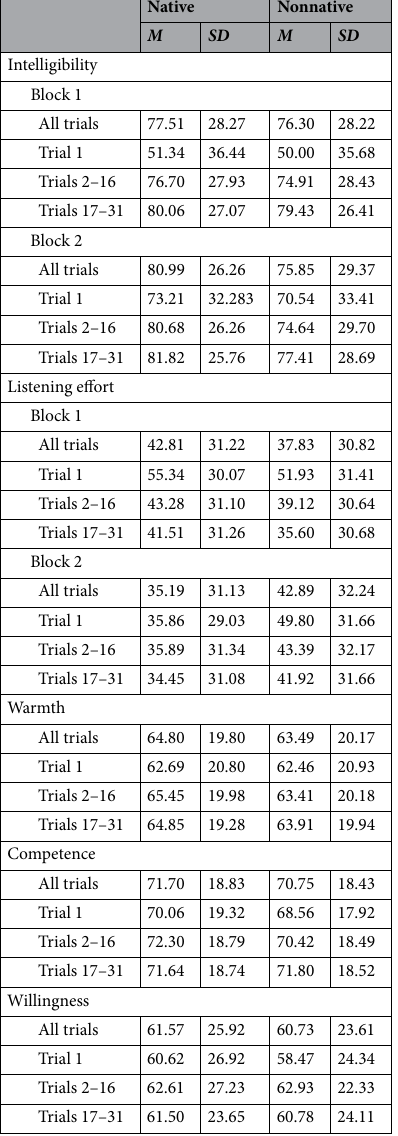
Table 1. Descriptive statistics for the raw values (i.e., not z-scored) of all dependent variables, separated by trial range (and, when appropriate, by block). M mean, SD standard